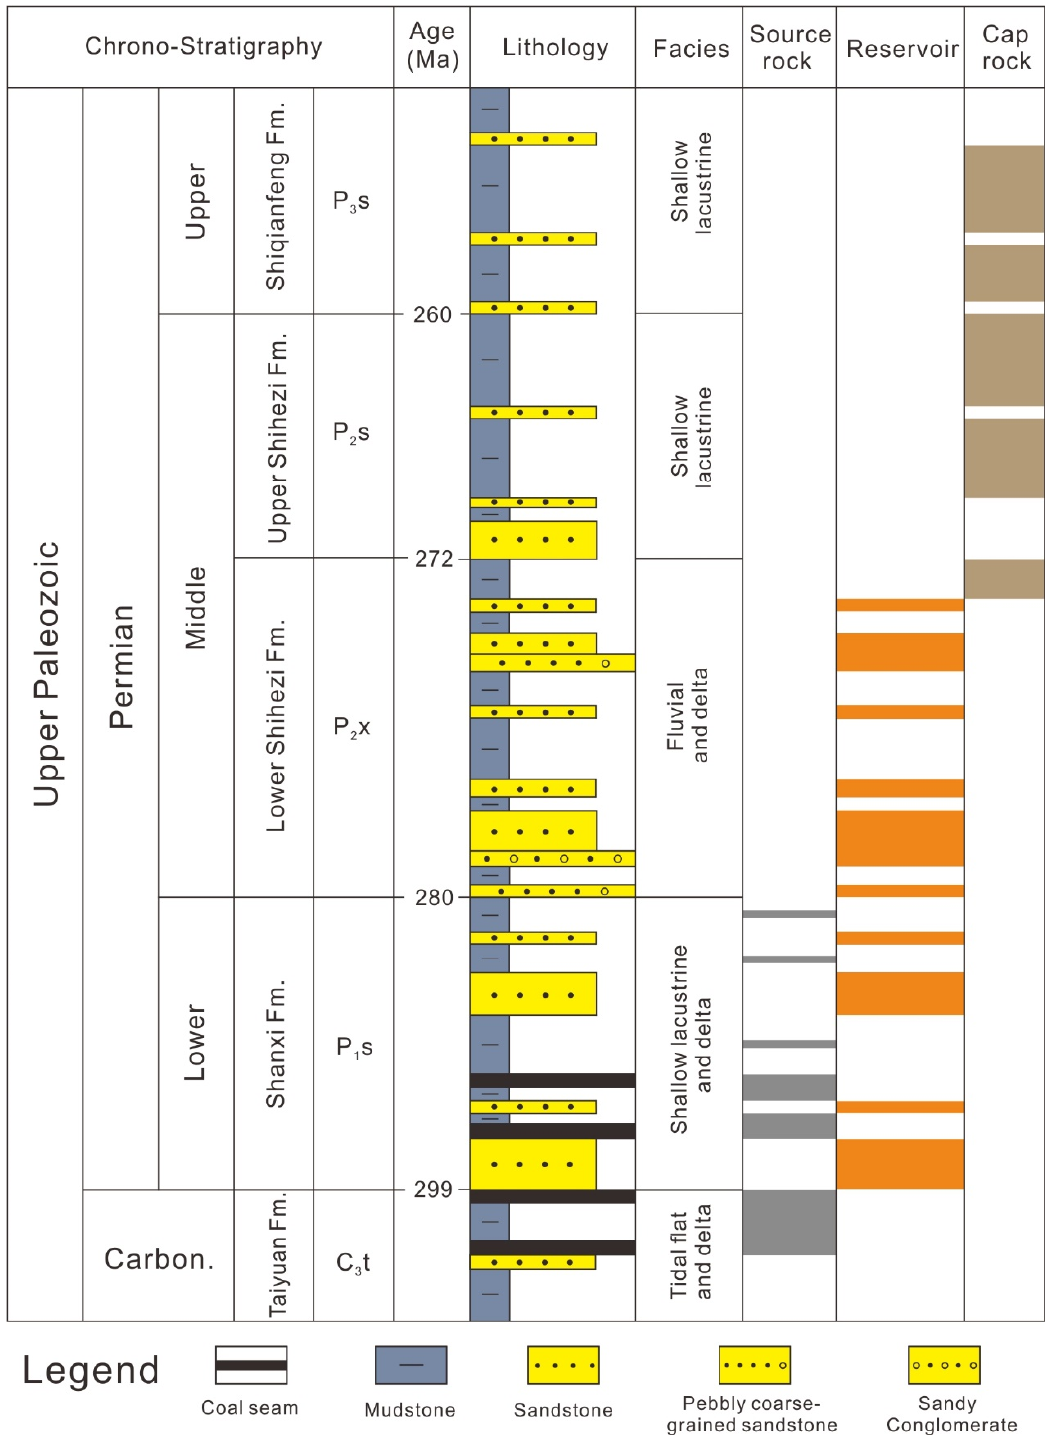
Figure 2. Generalized stratigraphy of the Upper Paleozoic successions in the Ordos Basin. Modified from Zhao et al. (2014) [32]and Wang et al. (2020) [18].